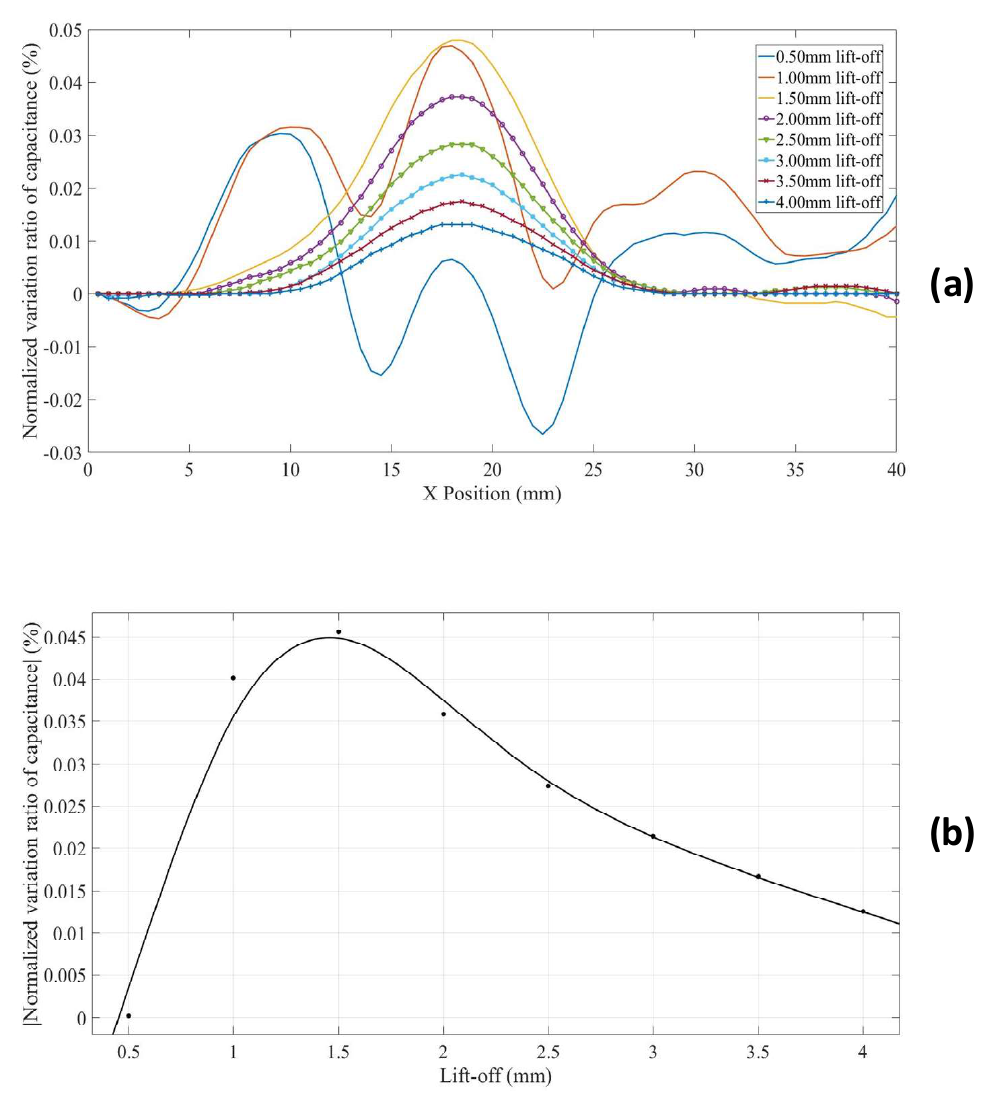
Figure 20. ( a ) NVR curves for the hidden 1.5 mm hole on specimen I (placed on a grounded conducting plate) with lift-offs increased from 0.5 mm to 4 mm ( b ) absolute values of the NVRs at the centre point against lift-offs.